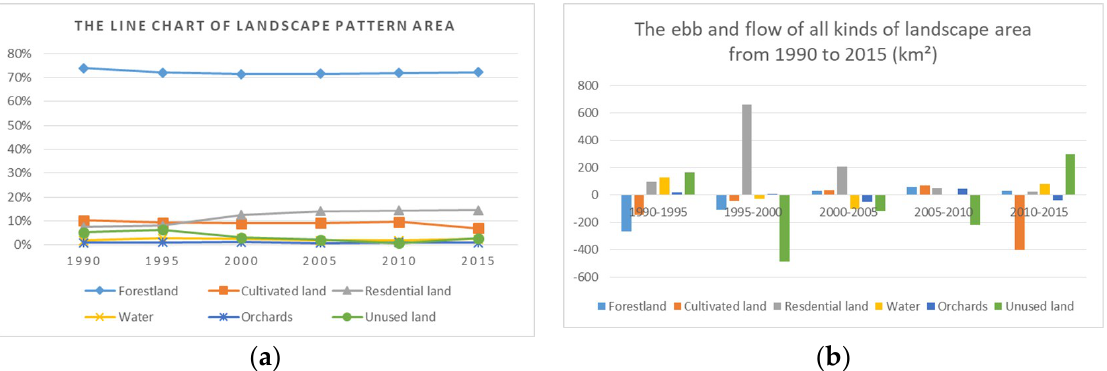
Figure 8. ( a ) The line chart of landscape pattern area percentage. ( b ) The ebb and flow of all landscape type areas from 1990 to 2015.